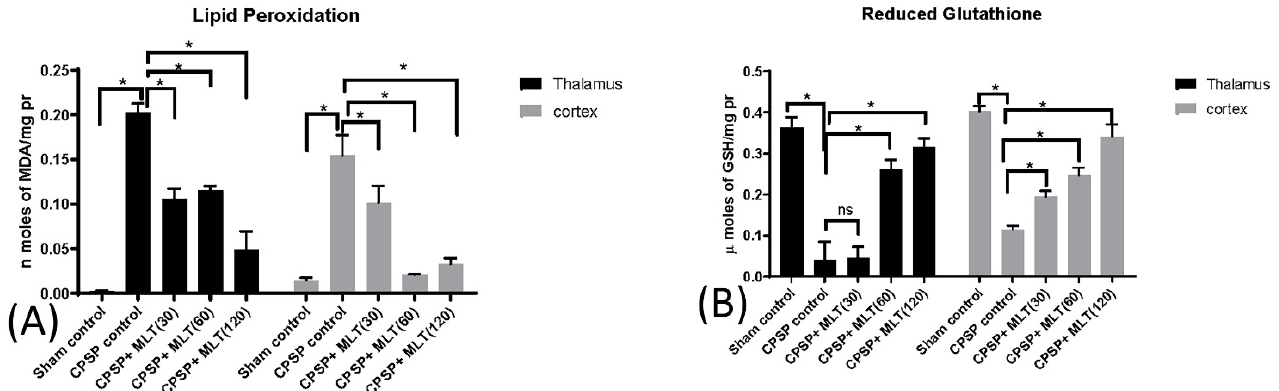
Figure 5. Effect of lesions and melatonin treatments on oxidative stress, including ( A ) lipid peroxidation (n = 5, per group) and ( B ) reduced glutathione (n = 5, per group) levels in the thalamus and the cortex after two weeks of melatonin administration. Data expressed as mean ± SD; * p < 0.005 as compared with CPSP.